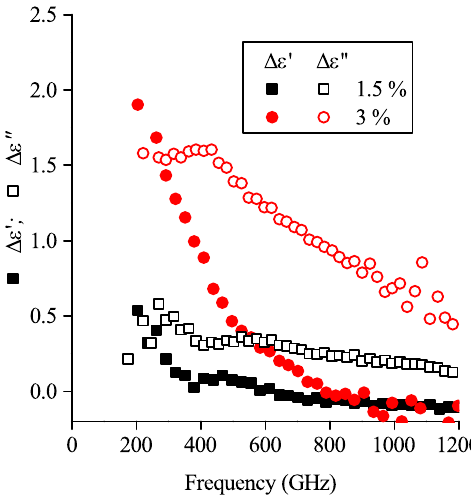
Figure 7. Impacts ( ∆ ε cp ) of cross-filler percolation to the dielectric permittivity of composites containing 1.5% MWCNT + 1.5 % GNP and 3% MWCNT + 3% GNP (referred to as 1.5% and 3%, respectively). Both real and imaginary parts behave typically for a percolated